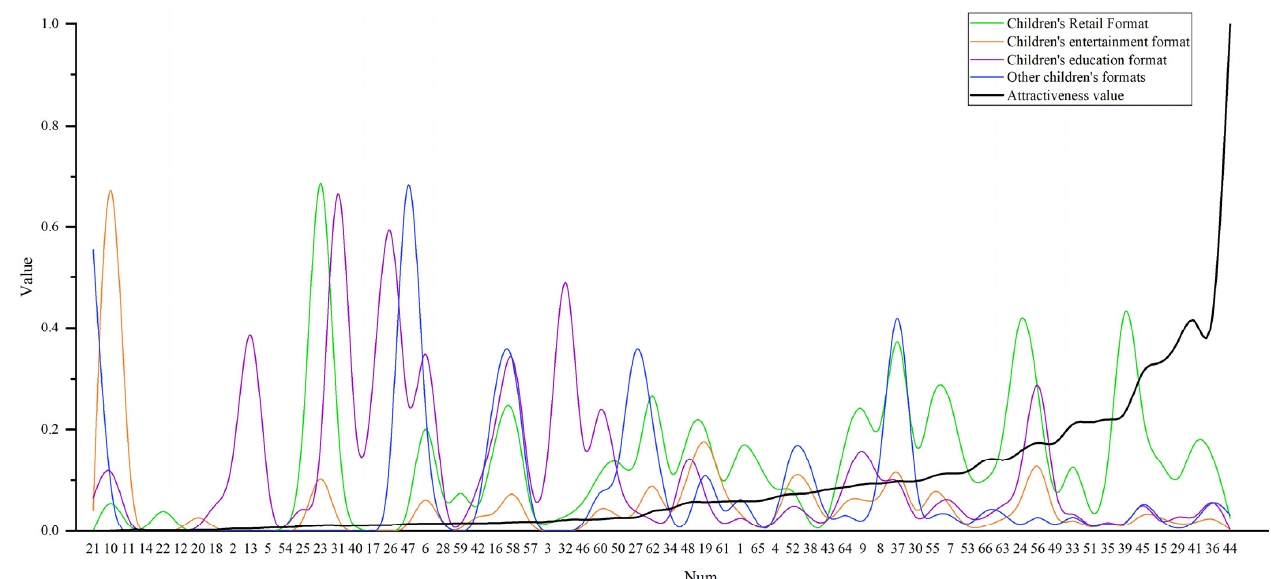
Figure 9. Line chart about the relationship between attractiveness and the clustering degree of children’s formats. Data sources: the field investigation data, AutoNavi Map API data, and LBS data.